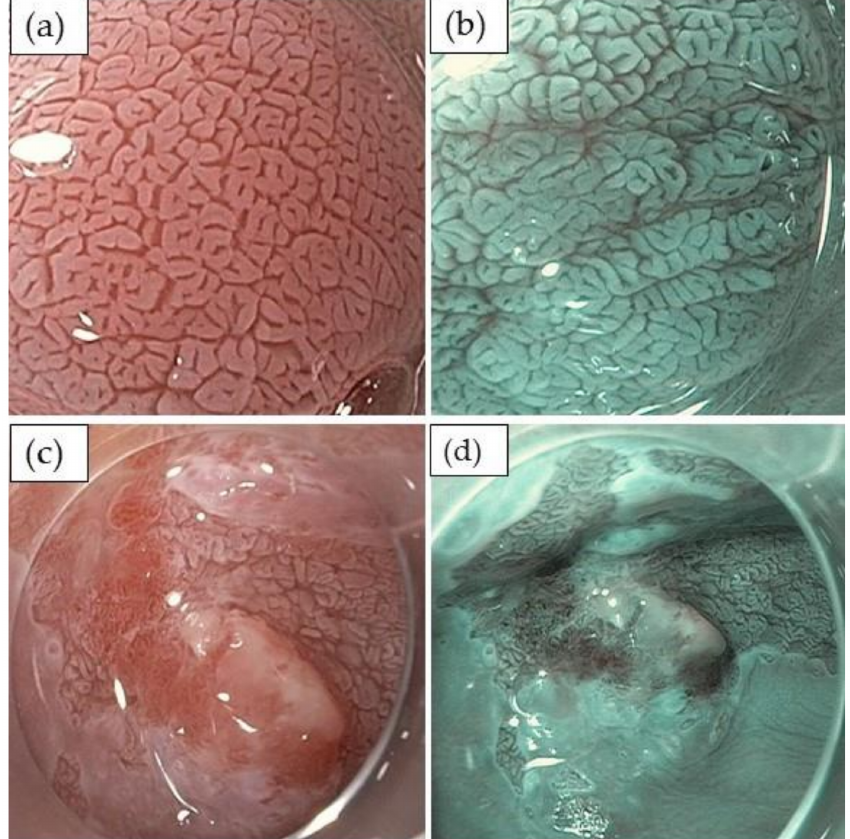
Figure 1. Endoscopic evaluation of Barrett’s esophagus and dysplasia with chromoendoscopy using 1.5% acetic acid. Top: non-dysplastic Barrett’s with a regular surface structure: ( a ) white light imaging, ( b ) narrow band imaging. Bottom: Barrett’s adenocarcinoma with the irregular surface structure and loss of acetowhitening: ( c ) white light imaging, ( d ) narrow band